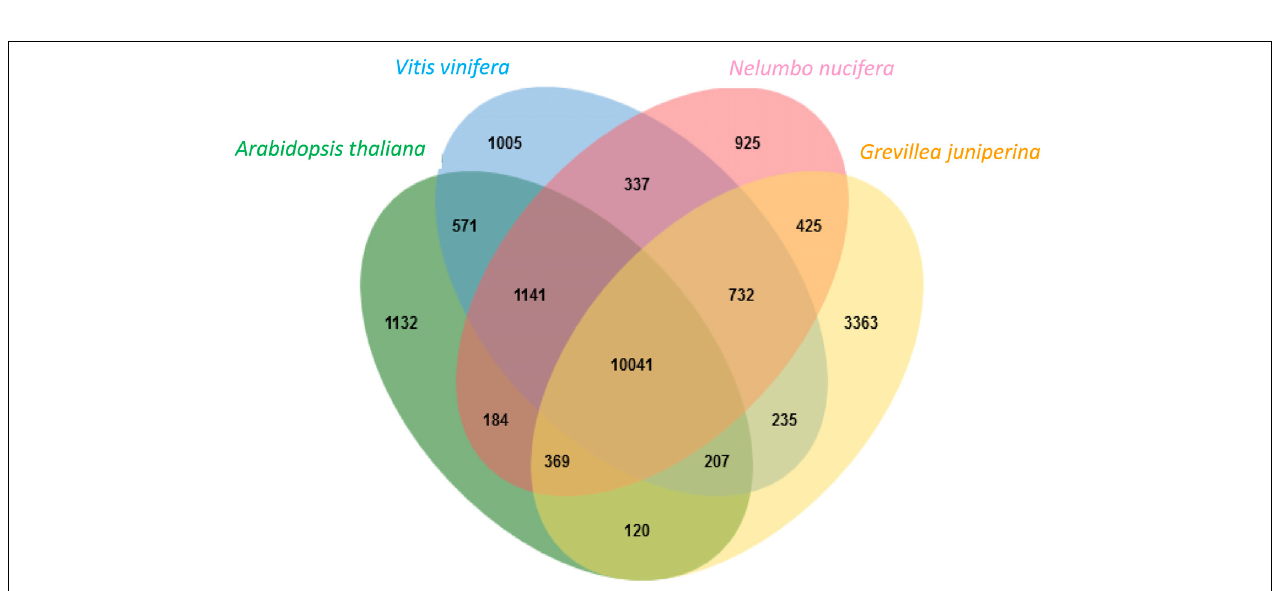
FIGURE 4 | Distribution of clusters (orthologous groups) between the Arabidopsis thaliana , Vitis vinifera , Nelumbo nucifera proteomes and the Grevillea juniperina leaf/flower proteome.